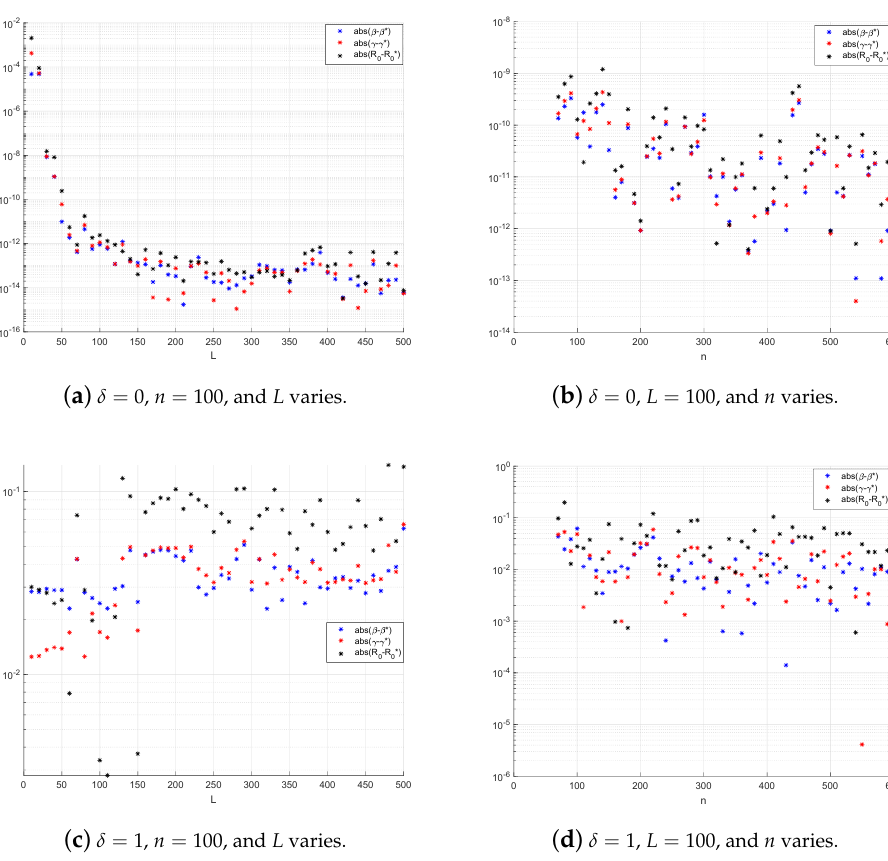
Figure 2. Monte Carlo simulations for SIR model with an ArcTan activation